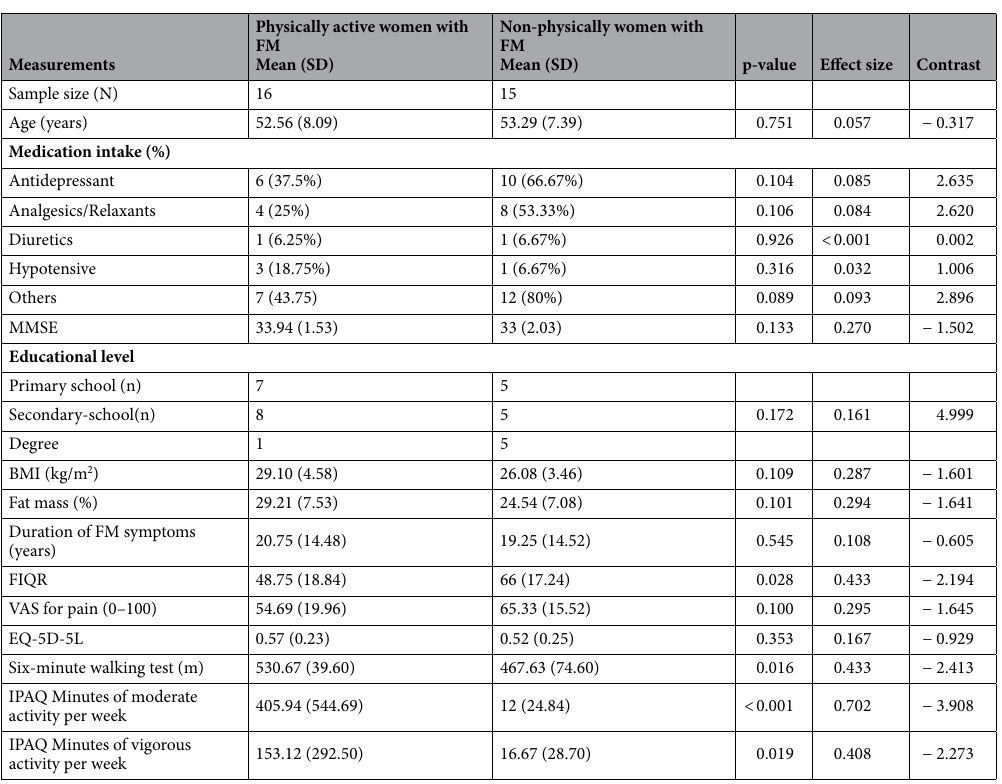
Table 1. Participants’ characteristics. BMI Body mass index, EQ-5D-5L Euroqol-5 Dimensions-5 Levels, MMSE Mini-mental State Examination, FIQR Fibromyalgia impact questionnaire, VAS Visual Analogue Scale.